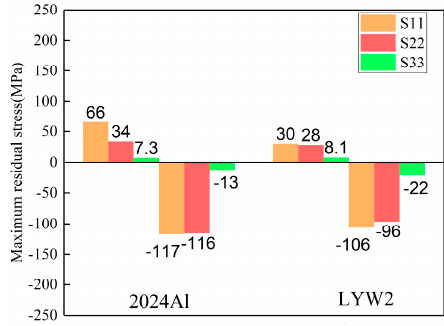
Figure 17. Maximum stresses of as-quenched 2024Al and W/2024Al blocks with thickness of 18 mm.